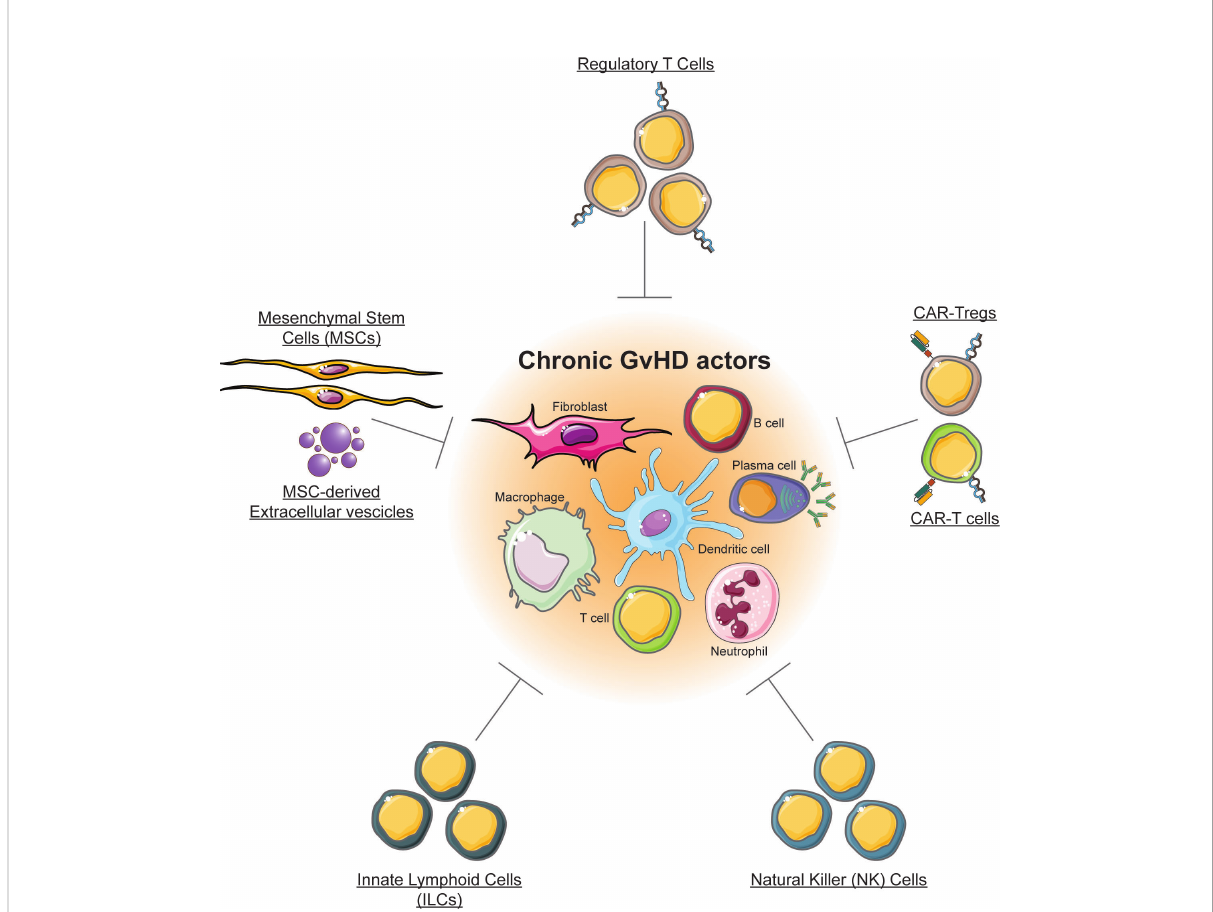
FIGURE 1 Cellular therapy for chronic GVHD. The fi gure illustrates cell types that are currently exploited or that can be exploited for chronic GVHD, and that are discussed in this